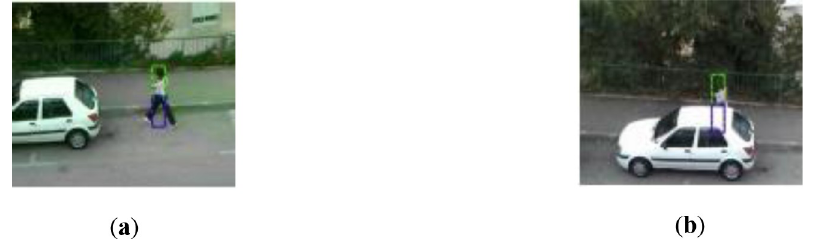
Fig 2. Different optimal tracker for one target in different frame, in ( a ) the globe tracker is better, in ( b ) the green sub- tracker should be